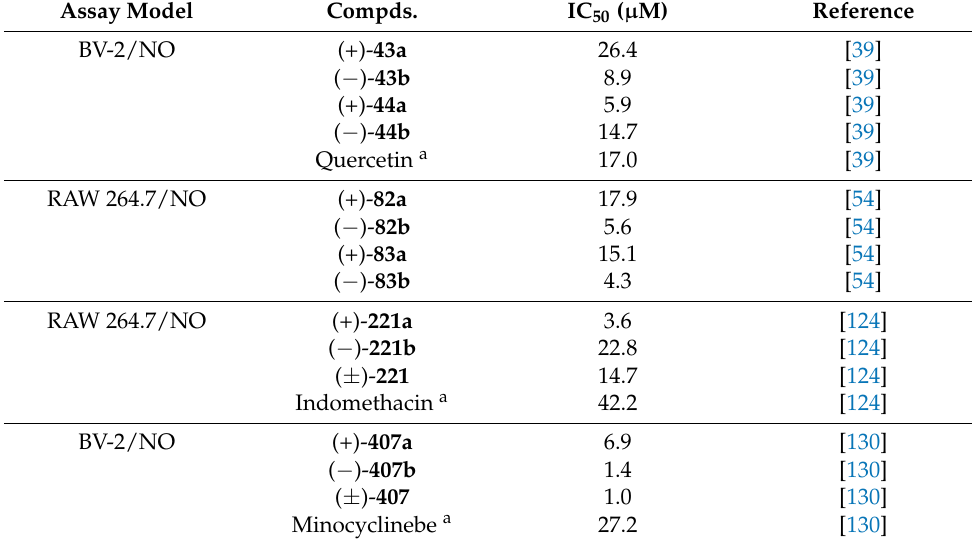
Table 6. Anti-inflammatory activities of enantiomers.